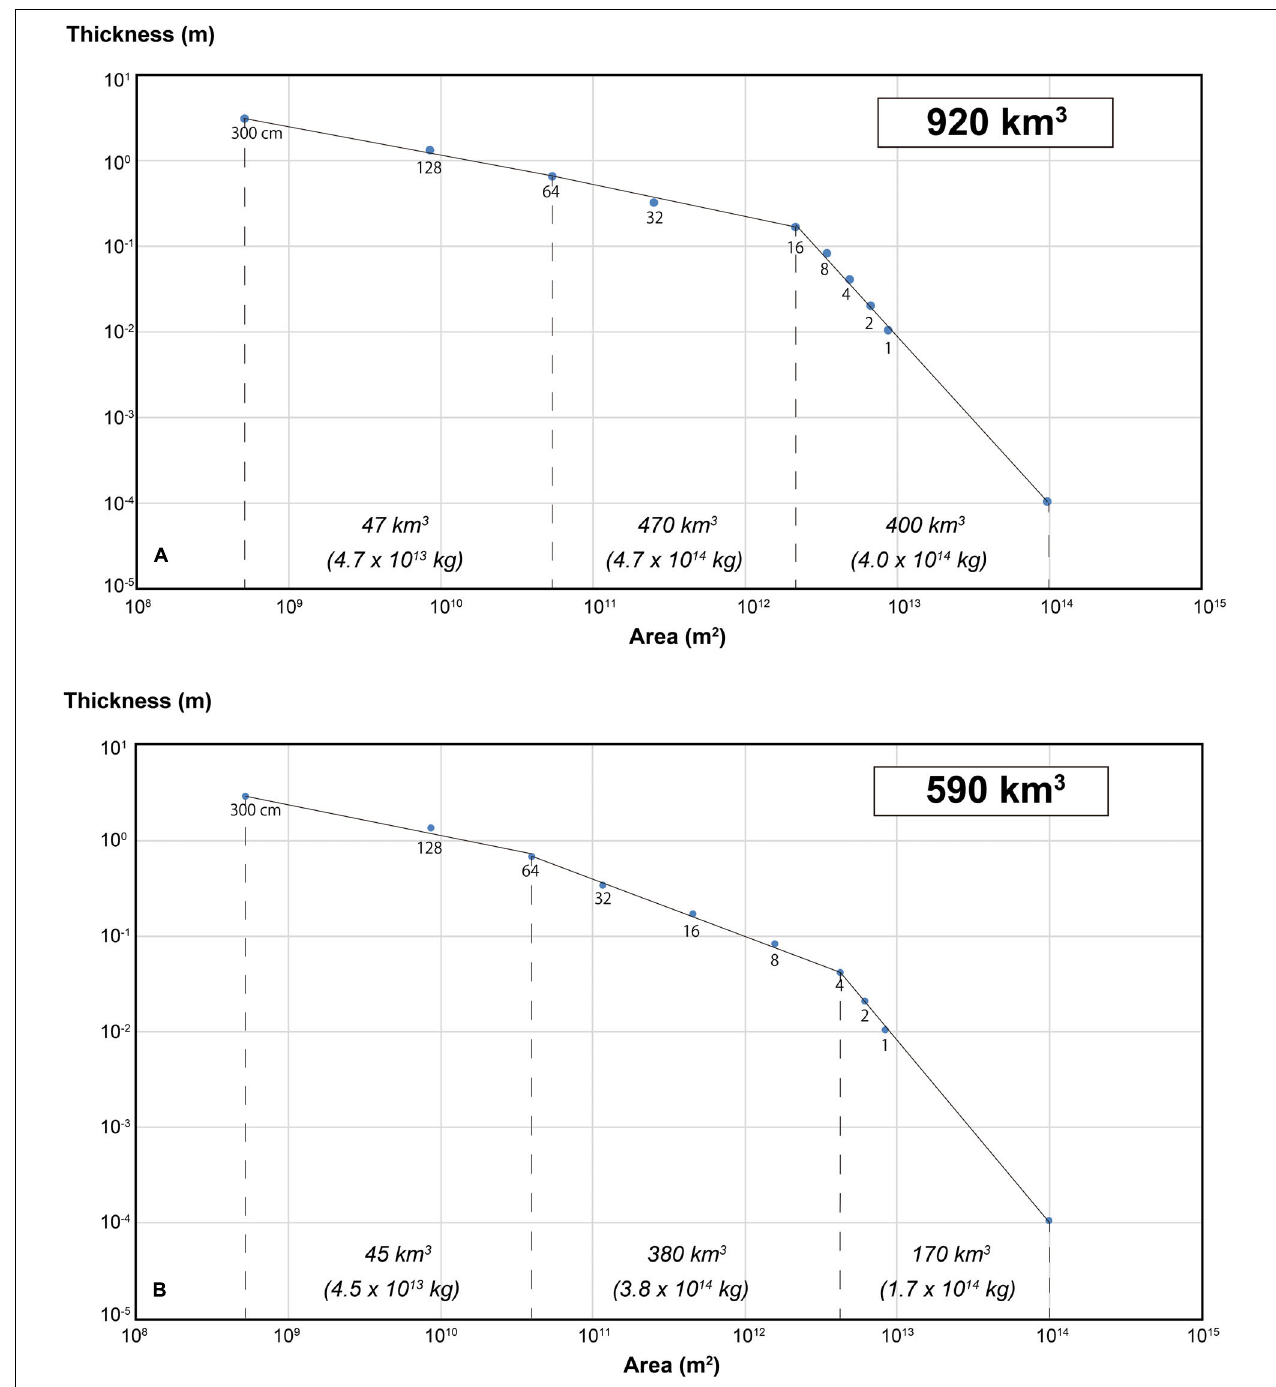
FIGURE 9 | Estimation results of Aso-4 tephra fall deposits using the segment integration method. Maximum case (A) and minimum case (B)